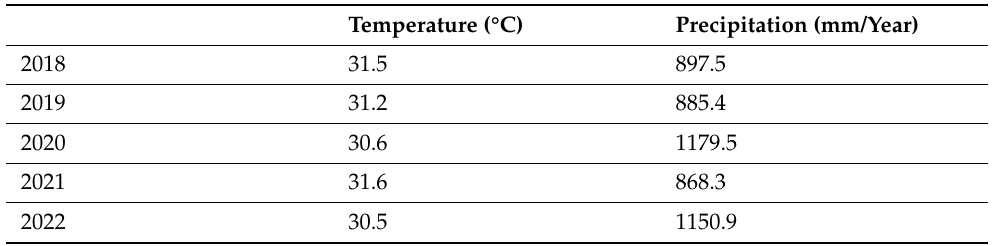
Table 10. Annual average temperature and annual precipitation in the Ayuquila River Watershed for